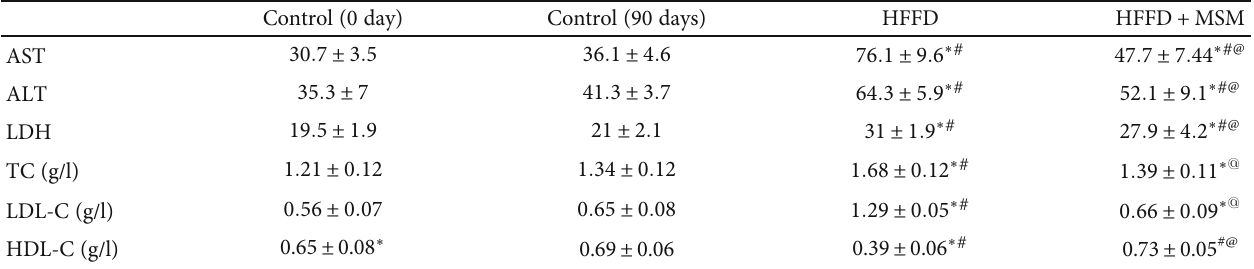
Table 2: AST, ALT, and LDH activities and TC, LDL-C, and HDL-C in plasma levels in control, HFFD, and HFFD rats treated with MSM.